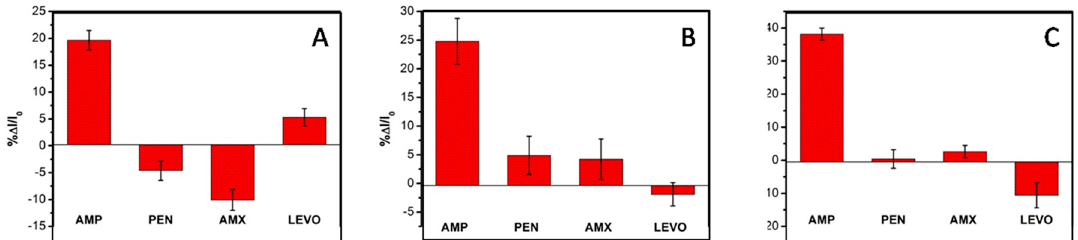
Figure 6. Histograms giving the current percentage after incubation in different interferents for ( A ) MoS2 based biosensor, ( B ) PPy based biosensor, and ( C ) MoS2/PPyNPs based biosensor.